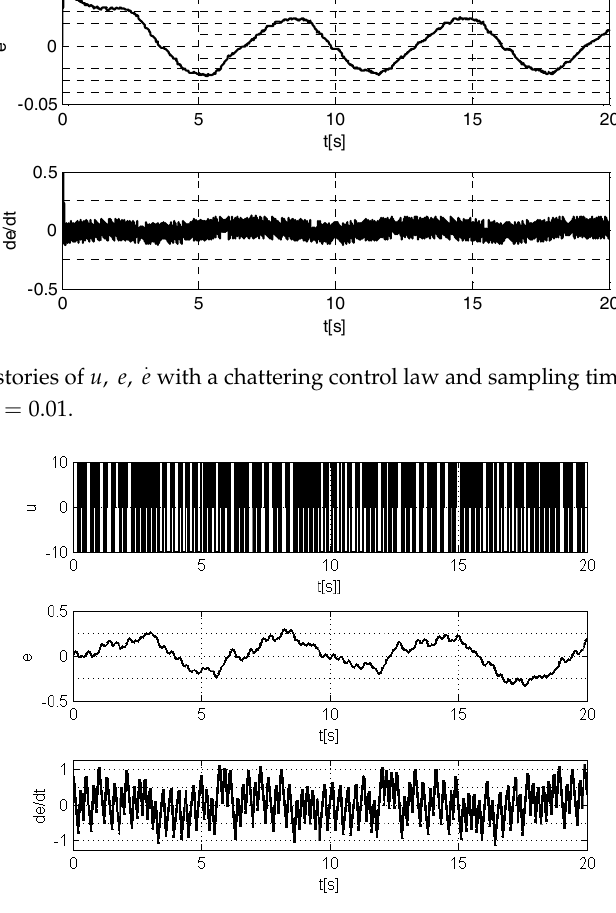
Figure A7. Time histories of u , e , e with a chattering control law and sampling time of the ZOH T = hold 0.10 T .